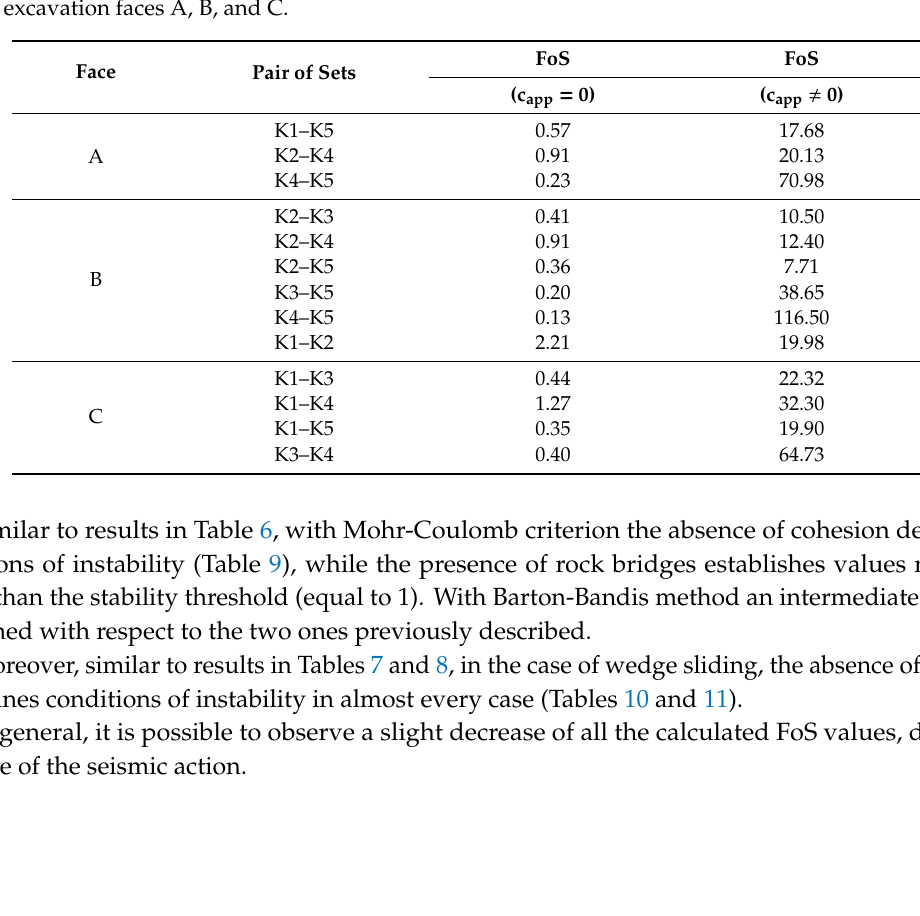
Table 11. FoS values obtained considering the presence of seismic action with respect to wedge sliding for excavation faces A, B, and